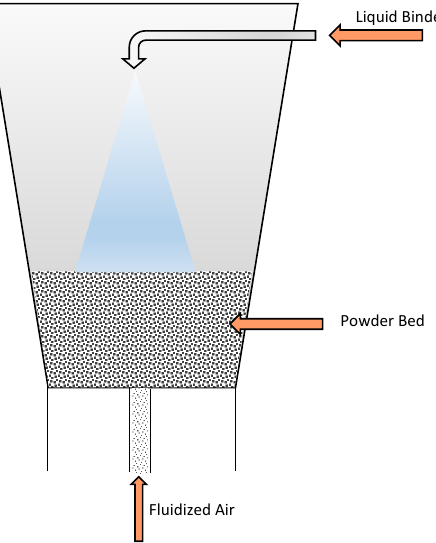
Figure 1. Top-sprayed fluidized bed